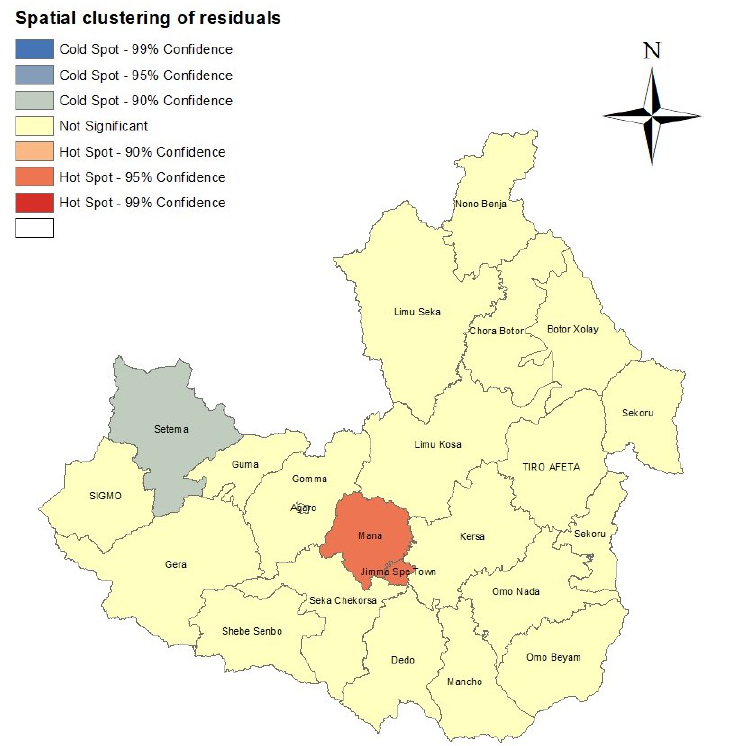
Figure 4. Spatial clustering of spatially structured residuals using the Getis–Ord